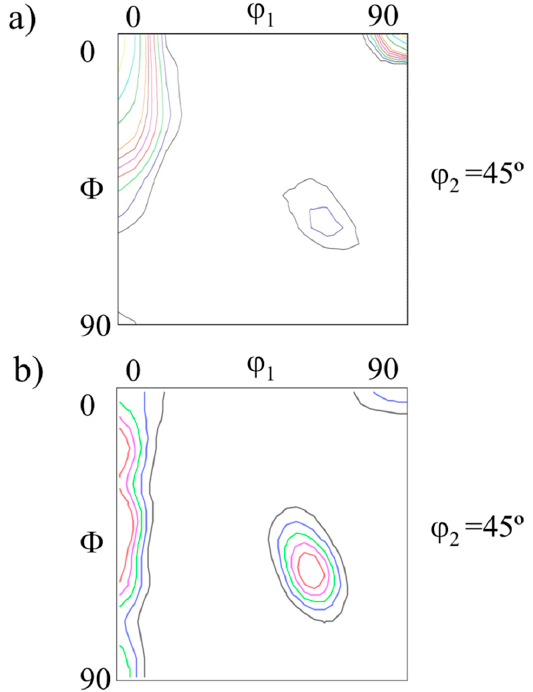
Figure 2. Orientation Distribution Fuction (ODF) at Φ 2 = 45 ° : ( a ) PM2000 alloy; ( b ) MA956 alloy.